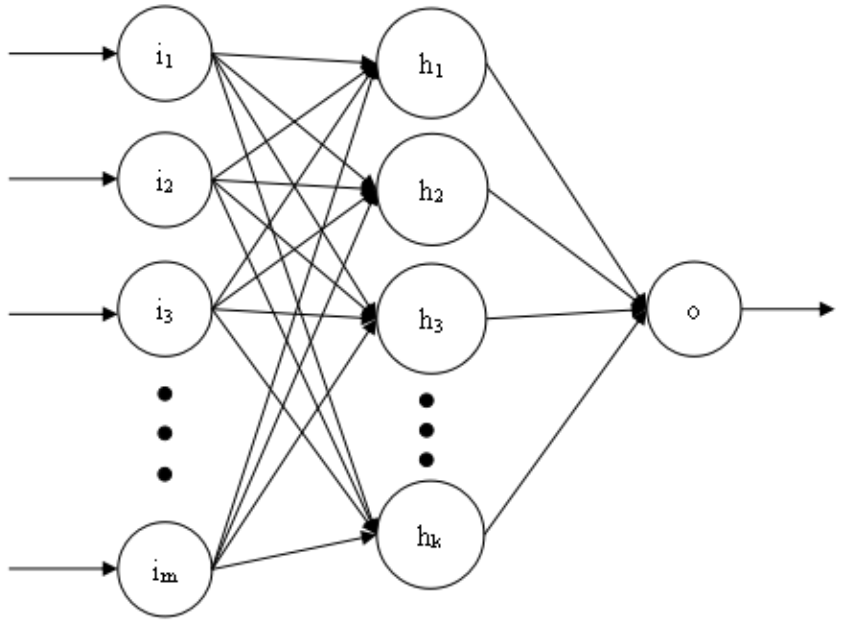
Figure 7. Three-layer single output BP neural network structure diagram. The model training process